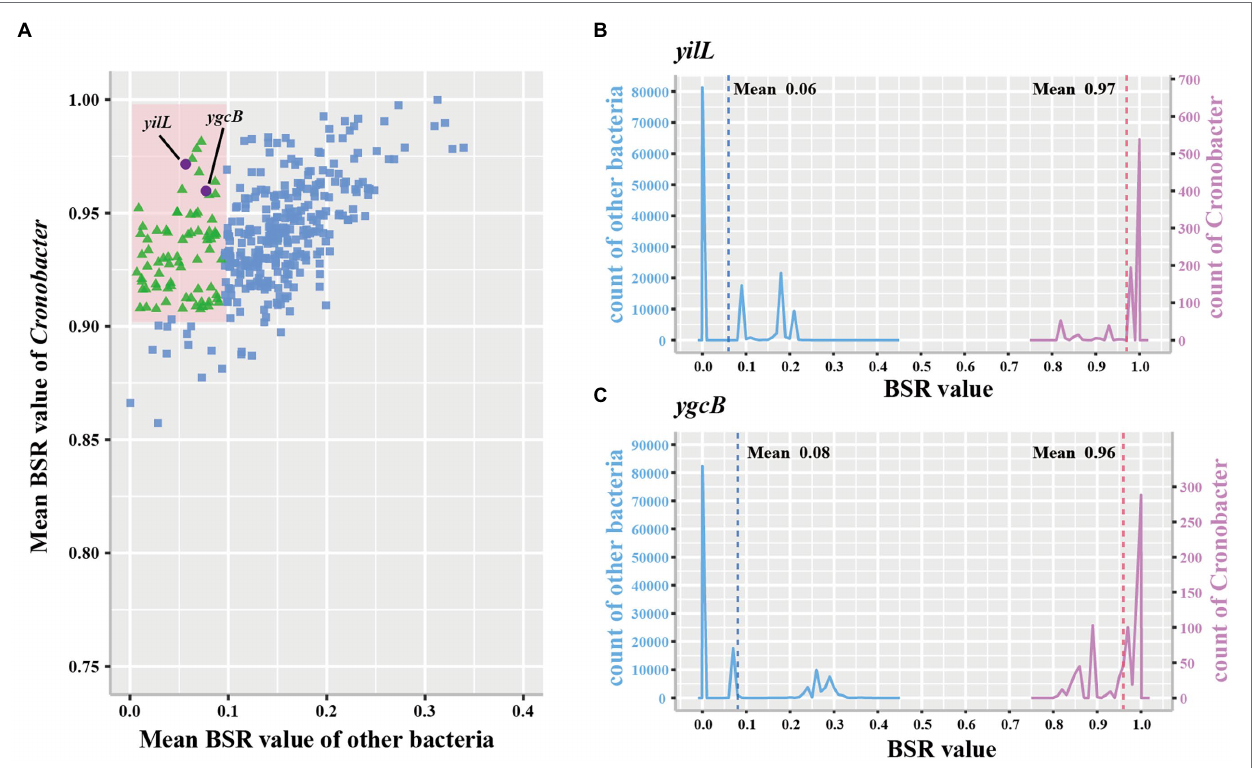
( Figure 4 ; Supplementary Table S4 ). To confirm specificity, 90 non- Cronobacter strains were tested and all produced no PCR products ( Supplementary Table S4